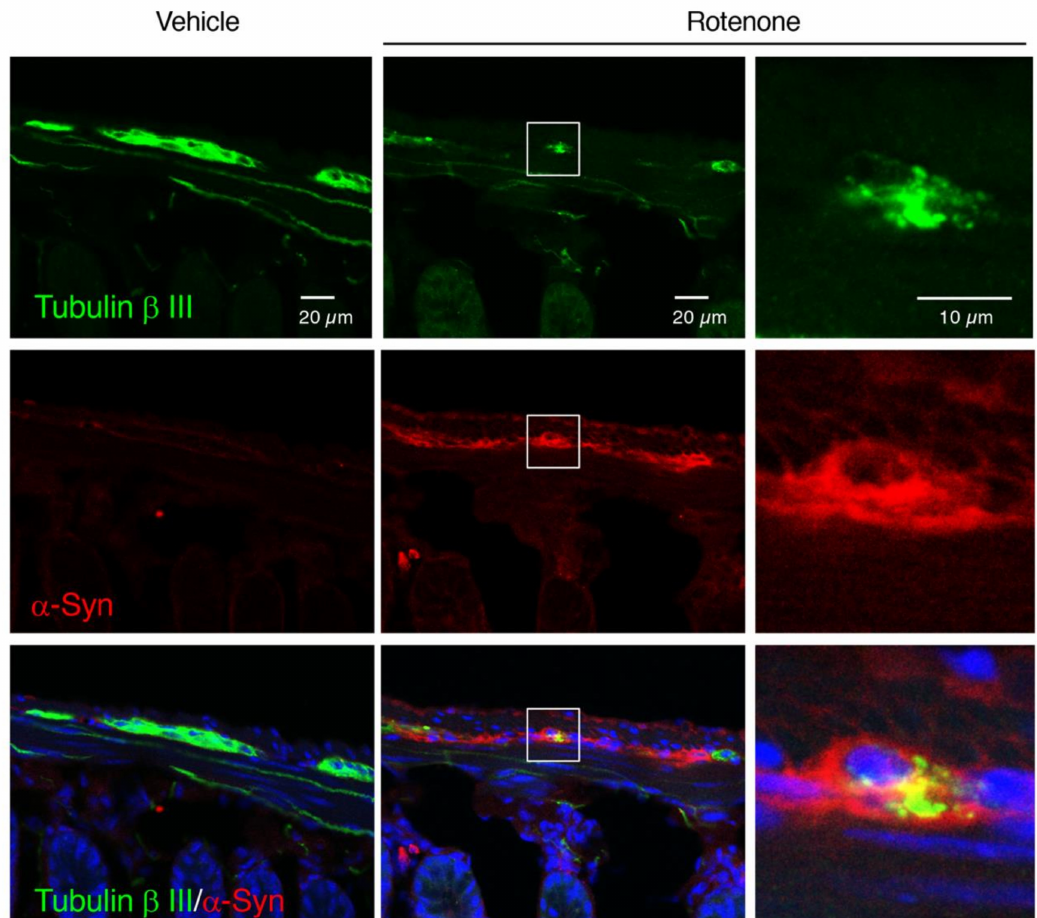
Figure 9. Chronic exposure to low-dose rotenone induced α -Syn accumulation in the intestinal myenteric plexus of mice. Representative photomicrographs of Tubulin β III and α -Syn double immunostaining. Green: Tubulin β III. Red: α -Syn. Blue: nuclear staining with Hoechst 33342. (Left, Center) Scale bar = 20 µ m. (Right) Magnified photographs of white boxes. Scale bar = 10 µ